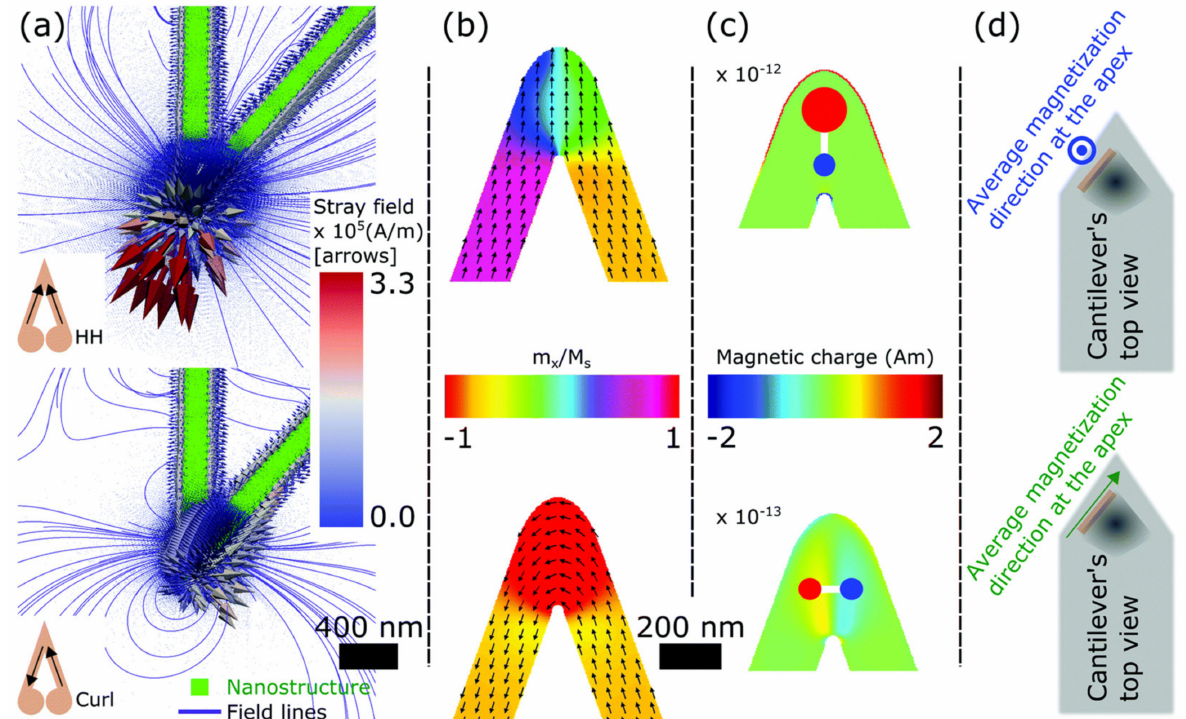
Figure 5. Numerically simulated magnetization and stray fields of suggested MFM probe. ( a ) Stray field created by the V-shaped magnetic nanostructure when magnetization is either in head-to-head state (top row) or curl state (bottom row). Corresponding images for ( b ) magnetization, ( c ) magnetic charge distribution, and ( d ) the direction of the stray field during MFM measurements. Reprinted from [59] and originally published under a CC-BY-NC